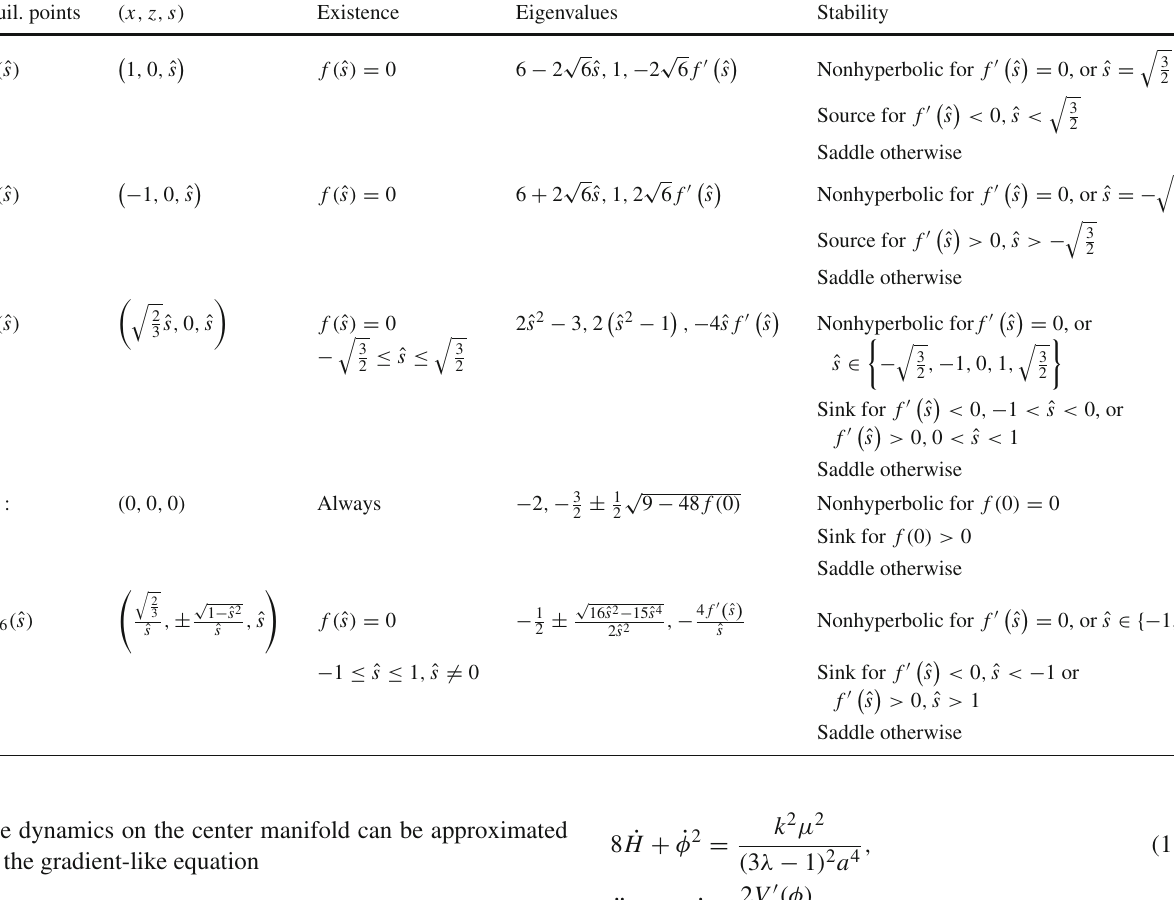
Table 3 Case 2: Equilibrium points at the finite region of the system (113), (114), (115) Equil. points ( x , z , s ) Existence Eigenvalues